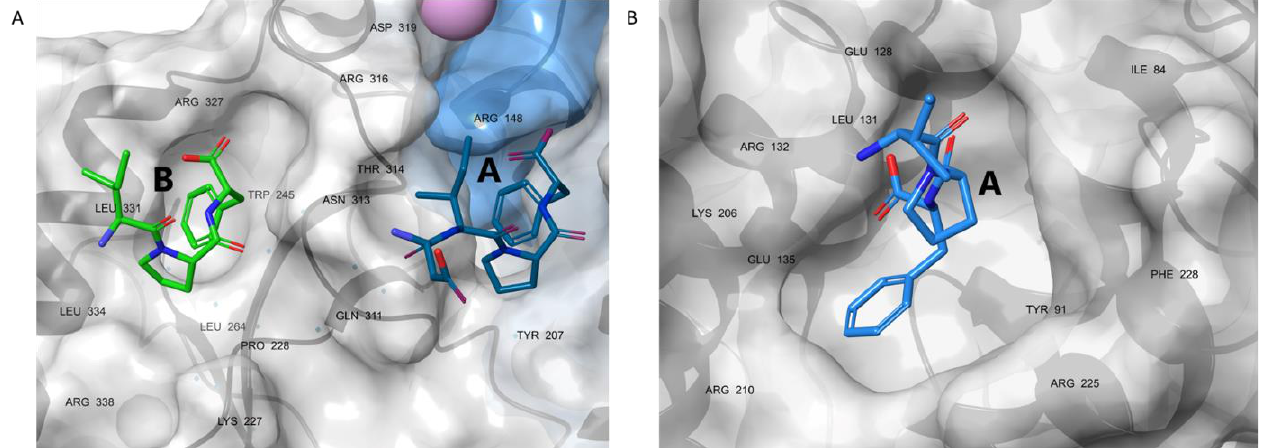
Figure 2. ( A ) The resolved C-terminal residues of wtSSB-Ct peptide (sticks) bound to sites A (DIPF) and B (IPF) of ExoI and their critical interacting residues (PDB structure 3C94). ( B ) Resolved C-terminal IPF segment of wtSSB-Ct peptide (sticks) bound to RecO (PDB structure 3Q8D). Interacting residues are labeled black. ExoI and RecO appear in the surface representation.